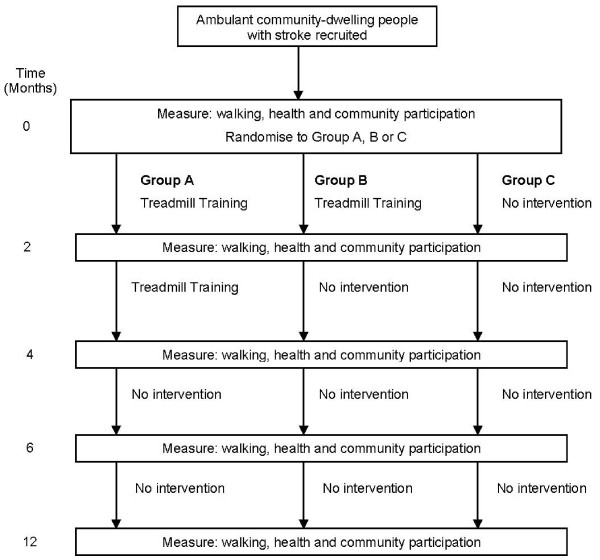
Design of study.